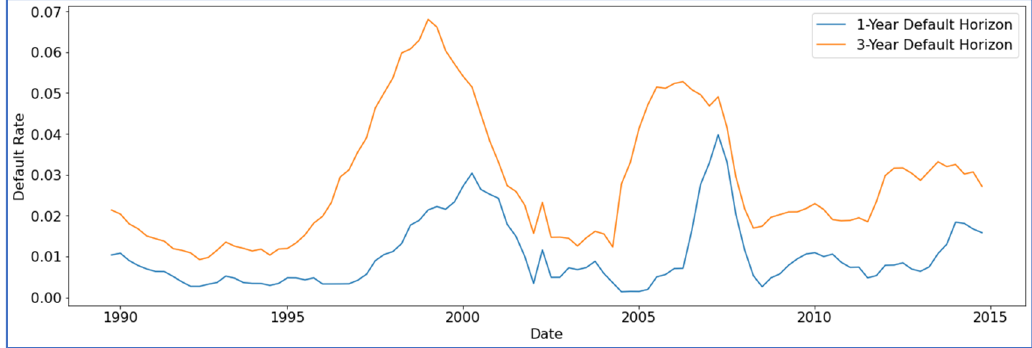
Figure 1. Large Corporate Modeling Data—One- and Three-Year Horizon Default Rates over Time (1991–2015).